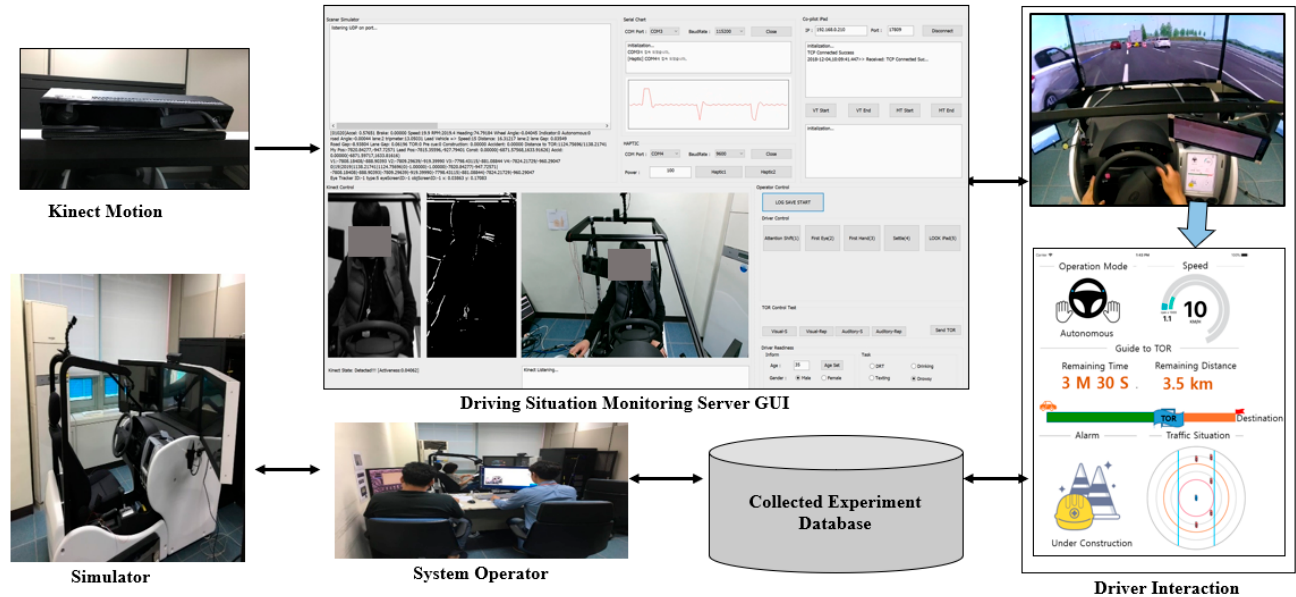
Figure 2. Experiment device and environment [10,15,18].